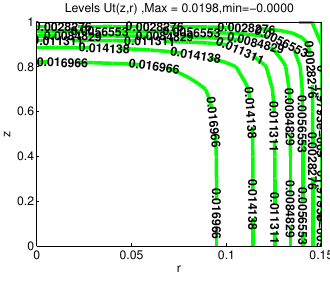
Figure 9. Averaging concentration u v ( r,z,t f ) depending on r for t f = 50